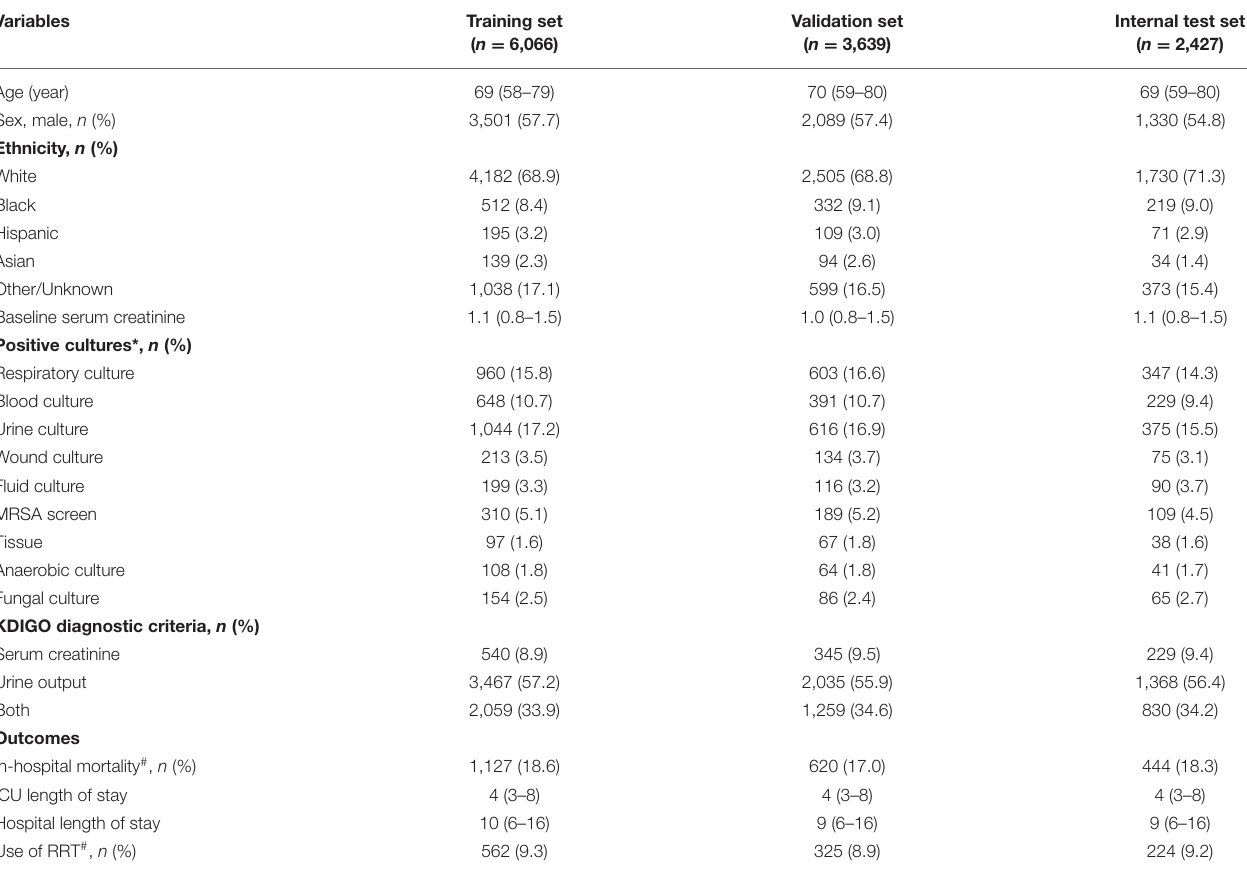
TABLE 2 | Baseline characteristics and outcomes of SA-AKI patients in the training, validation and internal test